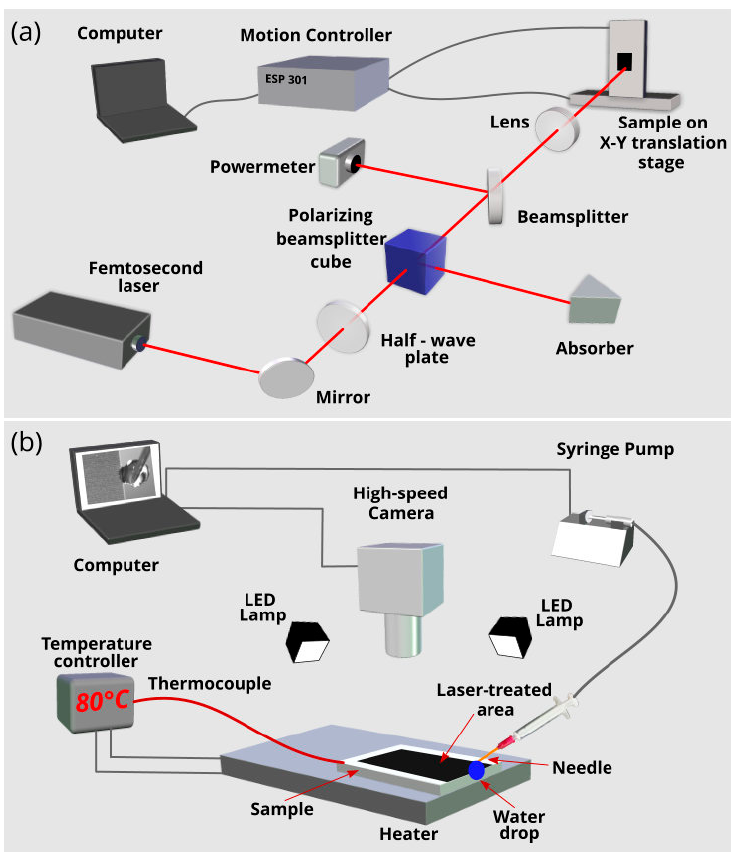
Figure 1. ( a ) Femtosecond laser setup for fabrication of the array of parallel microgrooves. ( b ) Experimental setup for high-speed video recording of capillary flow dynamics at various temperatures.